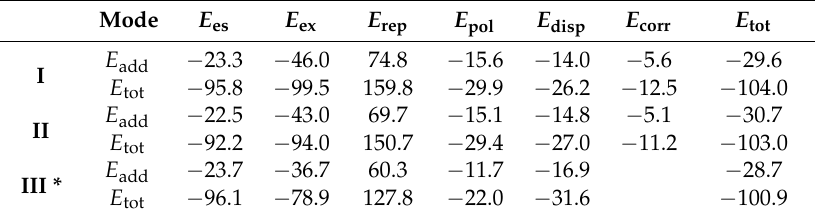
Table 2. The GKS-EDA results of I – III at B3LYP-D3/BS5 level (kcal/mol).